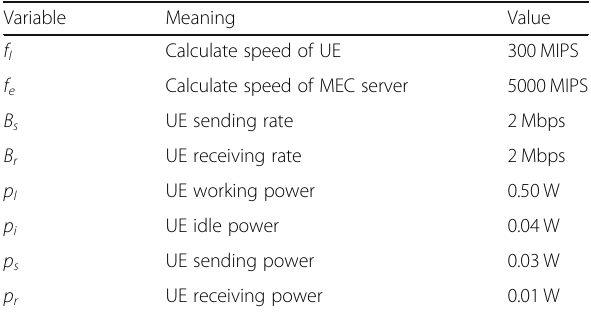
Table 3 Simulation parameters Variable